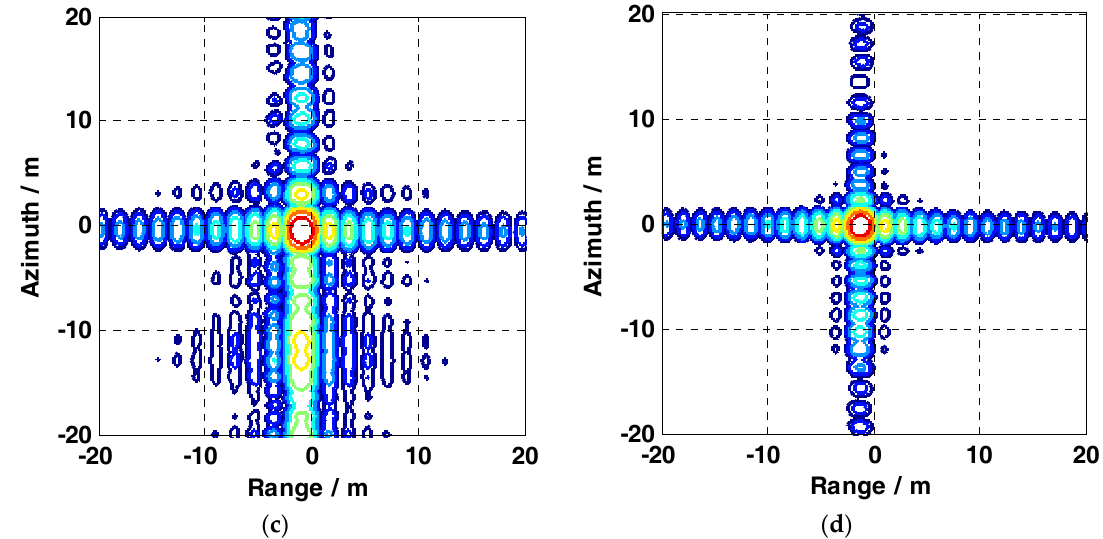
Figure 14. Target 5’s contours processed by ( a ) the conventional SAR imaging algorithm (CS algorithm), ( b ) MD algorithm, ( c ) PGA algorithm, and ( d ) BLUE algorithm, for sliding spotlight SAR data with burst-like perturbations.